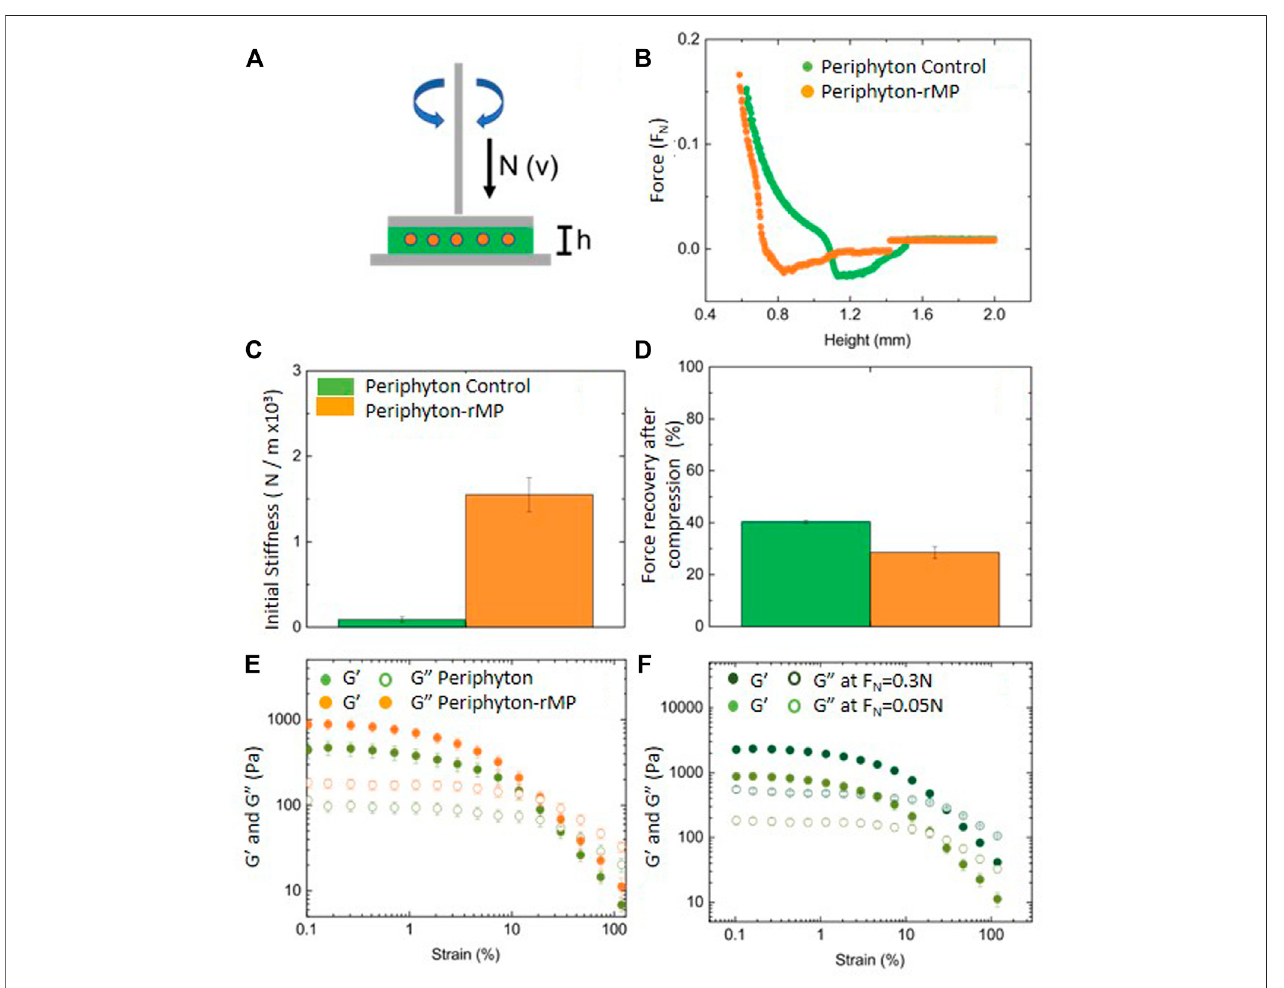
FIGURE5| MechanicalpropertiesofperiphytongrowingwithMP(periphyton-rMP,orange)andwithout(periphyton-control,green).Representedisasketchofthe rheometerindicatingtheplate,gap,sample,andsampleholder (A) ,therepresentativenormalforce (F N )dependenceonthegap (B) ,initialstiffness (C) ,stressrelaxation (D) and viscoelastic properties of the matrix of periphyton-rMP (orange) and (green) measured using amplitude sweeps with fi xed F N (E) and for periphyton-rMP at two different F N (F)